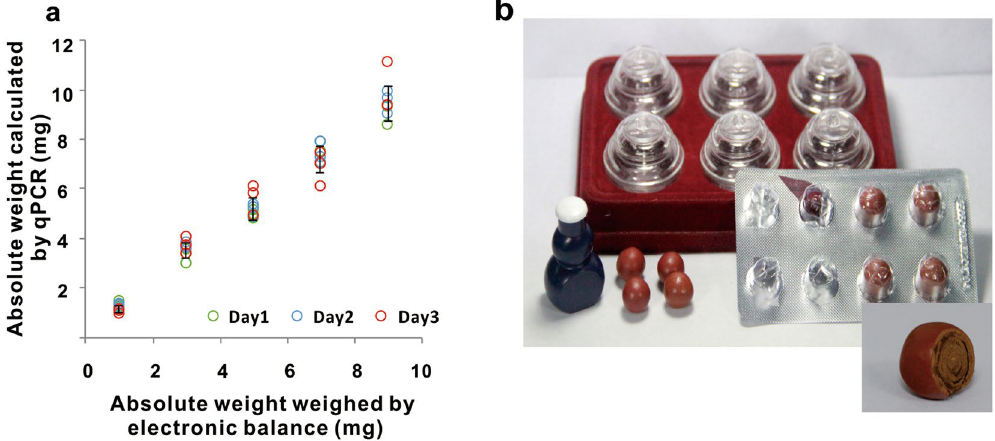
Figure 3. ( a ) Quantitative analysis of saffron in crude drug mixtures. The ratios of saffron to model adulterant in crude drug mixtures are 1 mg/9 mg, 3 mg/7 mg, 5 mg/5 mg, 7 mg/3 mg, 9 mg/1 mg respectively. Each color represents one day (independent weighing and DNA extraction) analytical results (day1, green; day2, blue; day3, red). Error bars represent ± s.e.m. ( b ) Photos of Tibetan medicine “Ershiwuwei Shanhu